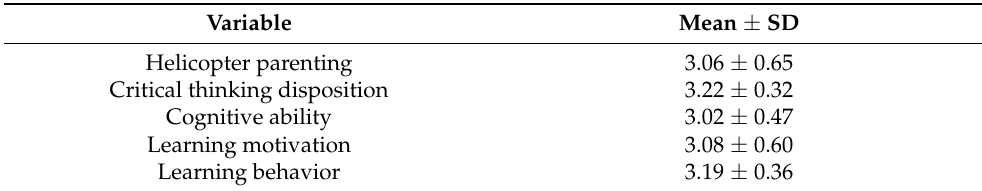
Table 2. Levels of helicopter parenting, critical thinking disposition, cognitive ability, learning motivation, and learning behavior ( n =